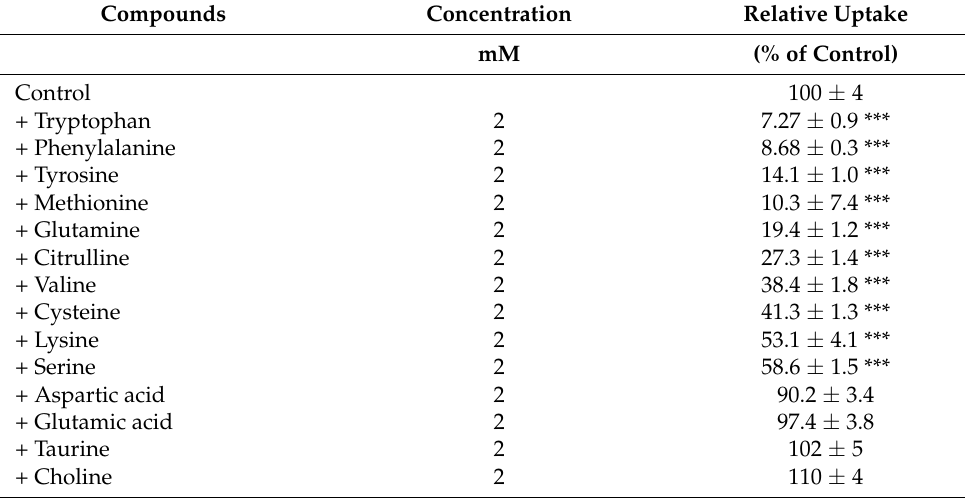
Table 3. Effect of various compounds on [ 3 H] L -tryptophan uptake by TR-BBB cell lines. Compounds